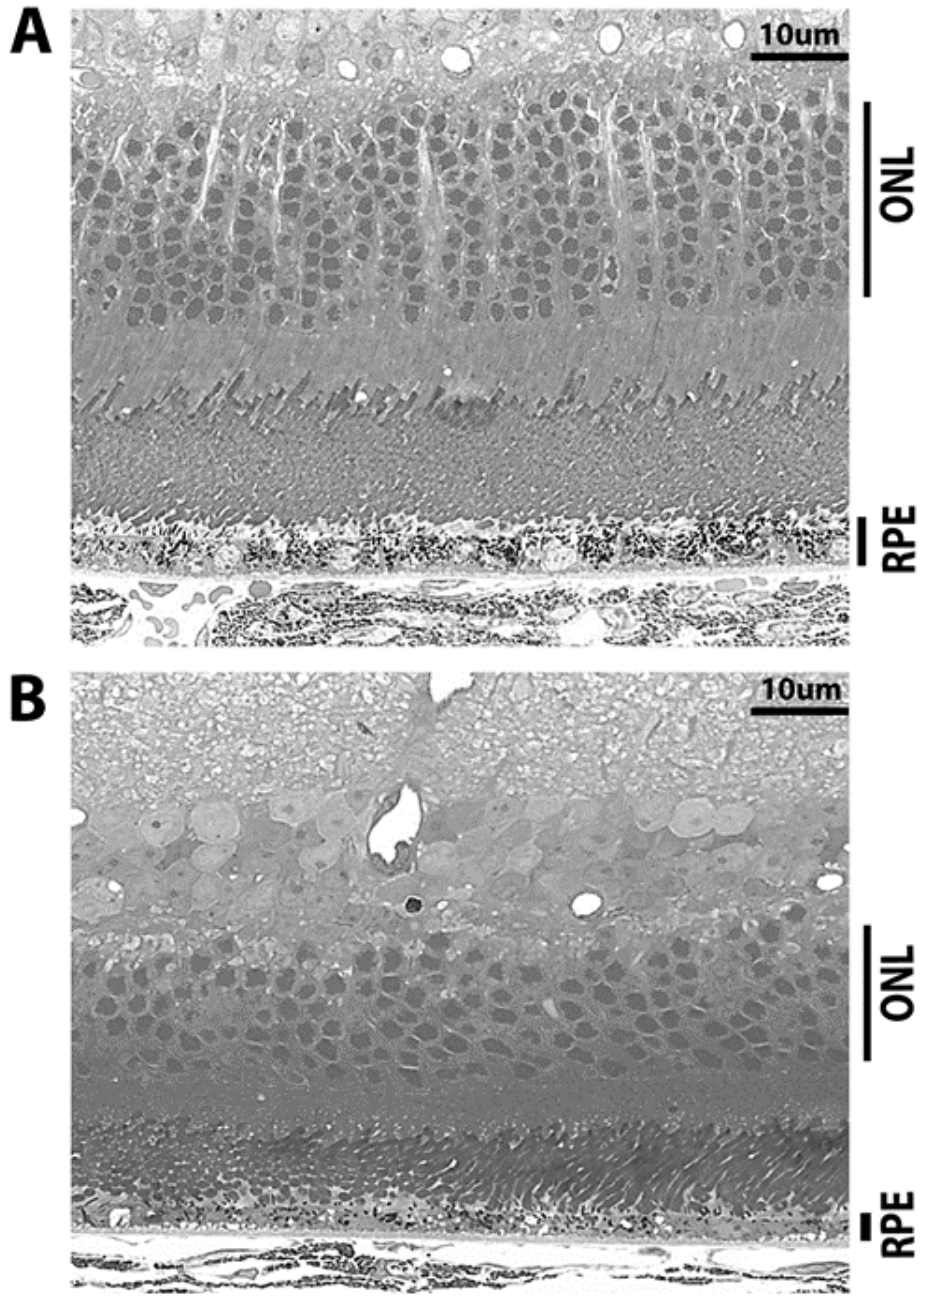
Figure 5. Photoreceptor and RPE preservation in AAV-EPO injected eyes. ( A ) represents the retinal sections from AAV- EPO injected eyes and ( B ) represent retinal section from AAV-GFP injected eyes. Scale bar 10 μm.